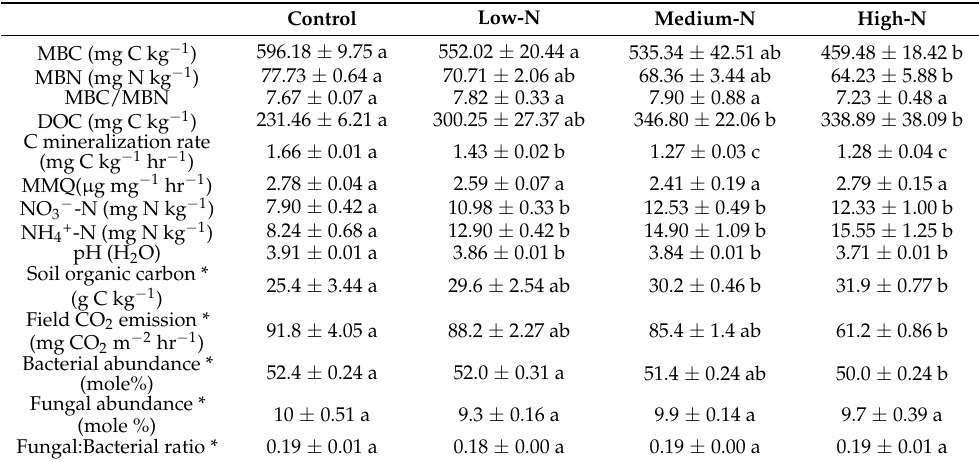
Table 1. Responses of soil carbon mineralization, soil microbial biomass, and soil properties at 0–10 cm layer to long-term N additions in the N-rich mature tropical forest of Southern